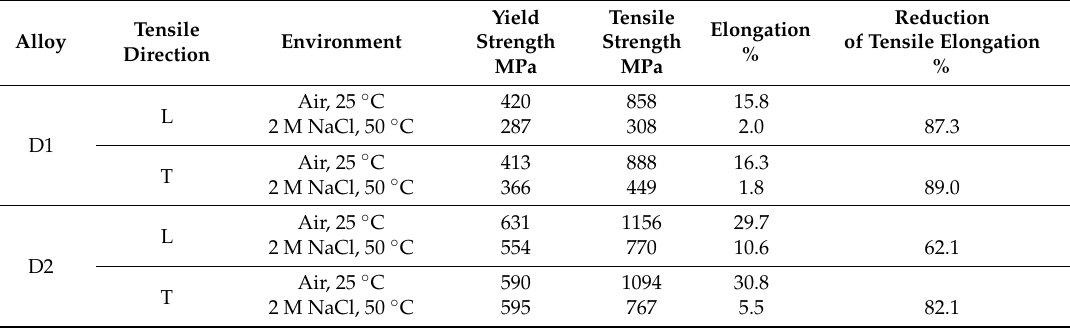
Table 2. SSRT conditions and the results for D1 and D2 specimens along L and T directions.